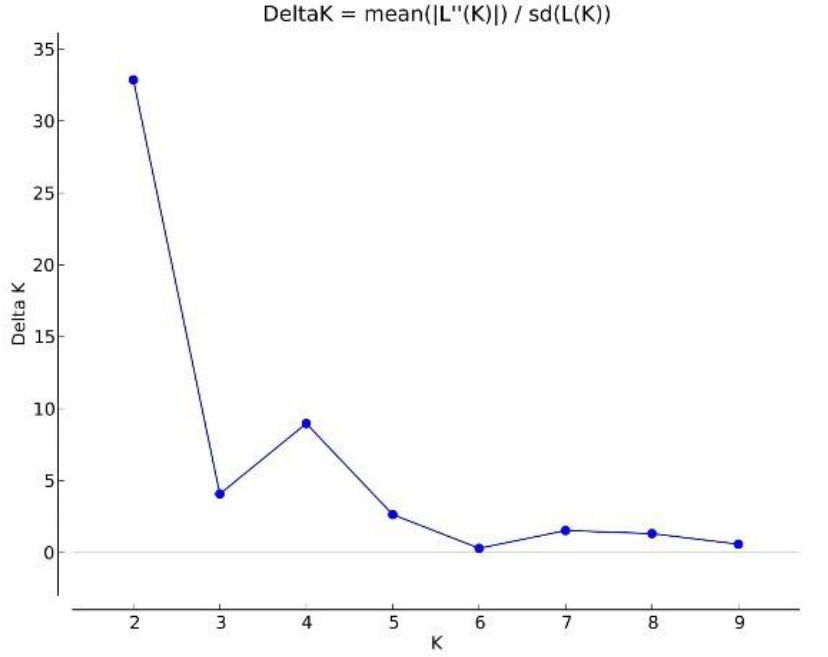
Figure 2. Results from Structure Harvester analysis of pedunculate oak populations (K = 2). The results of STRUCTURE revealed two pedunculate oak gene pools in Serbia (Fig- ure 3). Group I included populations from MO, OD, KL, whereas group II included pop- ulation in KG, KU, AP, and BM.